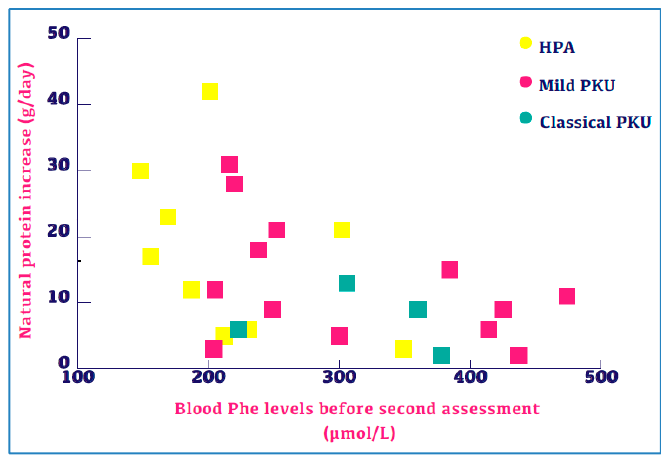
Figure 2. Twenty-six subjects with increased natural protein presented by age and severity of disorder.